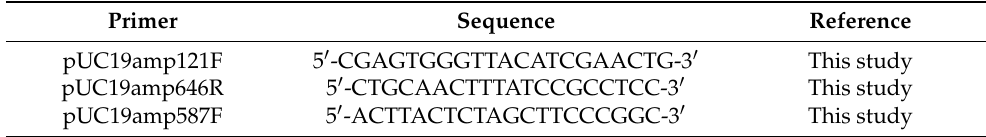
Table 1. Primer sets used for PCR and qPCR assays in this study.